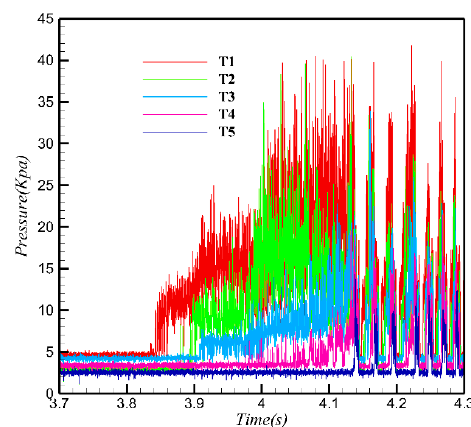
Figure 11. Overview of pressure time history of T1 to T5 (3.7–4.3 s).